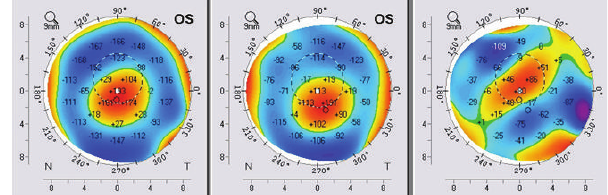
Figure 14: SOCT anterior: 10 months after